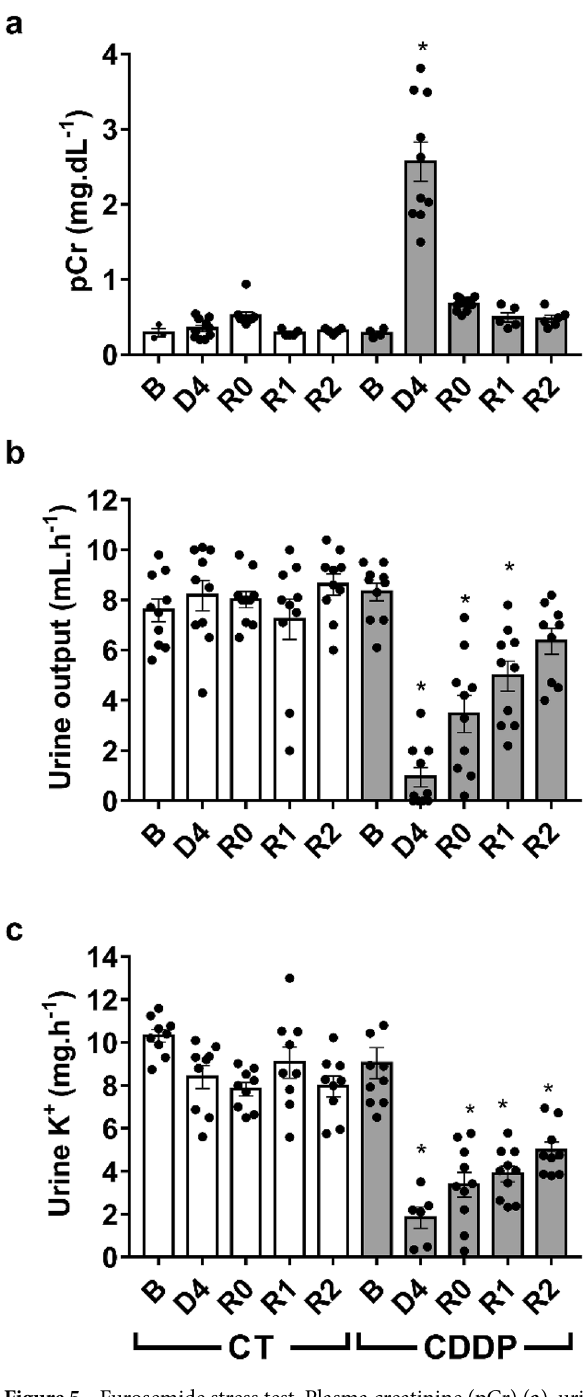
Figure 5. Furosemide stress test. Plasma creatinine (pCr) ( a ), urine output ( b ) and urinary potassium excretion ( c ) after administration of furosemide (20 mg kg −1 , i.p.). B basal, CDDP cisplatin treatment (5 mg kg −1 )